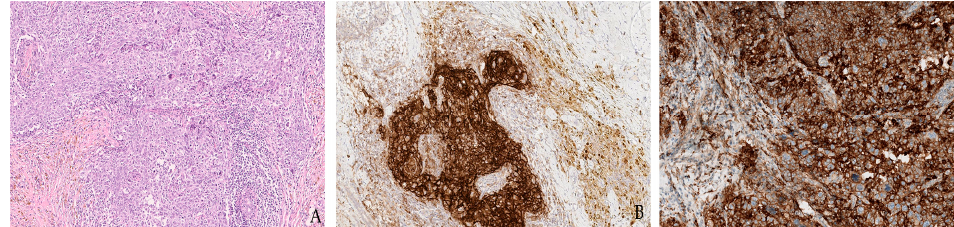
Figure 2. Representative microphotographs of a poorly differentiated (G3) triple-negative breast cancer of no special type ( A ) showing the different patterns of PD-L1 immunohistochemical staining using a 22C3 clone on a Dako Autostainer Link 48 ( B ) and an SP263 clone on a Ventana BenchMark Ultra ( C ) for combined proportion score (CPS) testing.